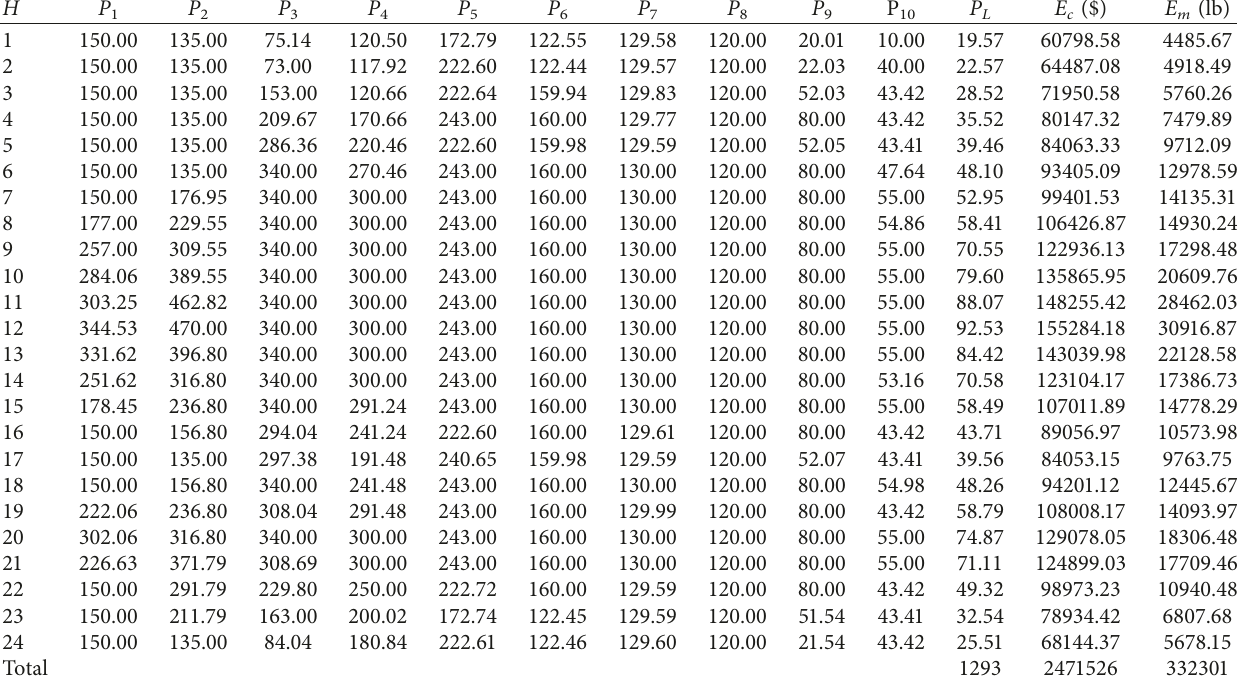
Table 6: Optimal results for Case 2 (optimal